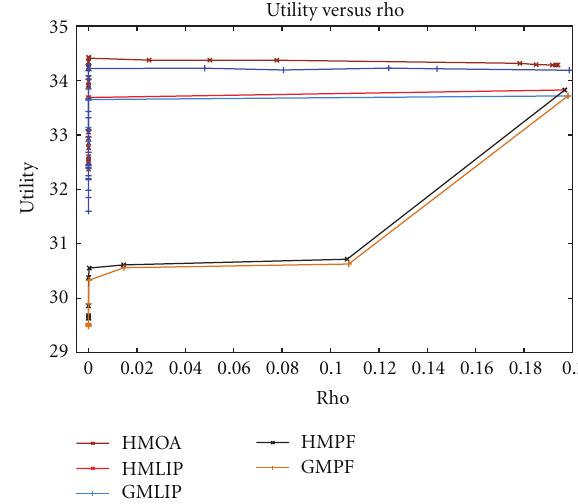
Figure 11: Utility ( (cid:26) Ψ ) versus Rho ( (cid:27) ρ d ) when queue length = 500.